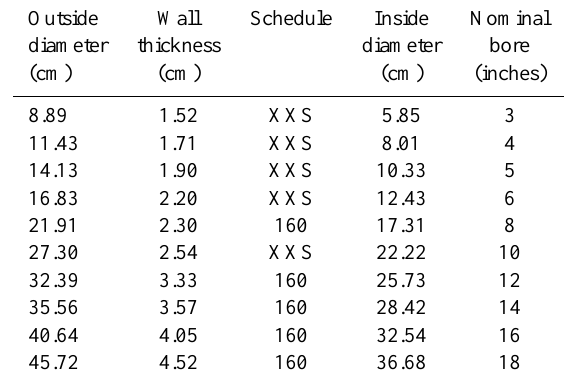
Table A1. Intake pipe specifications used to generate Figs. A3 and